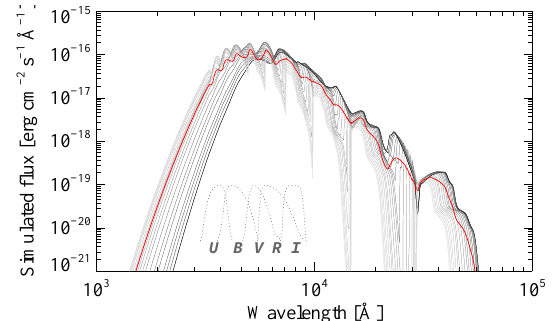
Figure 2: Spectral models of cyclotron emission for B = 36 MG, ˙ m = 0 . 01, 1 . 0 g cm − 2 s − 1 , and the es- timated accretion geometry of RS Cae: orbital mean (red) and phase-resolved from ϕ mag = 0 . 0 (light) to 0 . 5 (dark). Dotted: Johnson filter bandpasses, used to de- rive the light curves in Fig. 3.